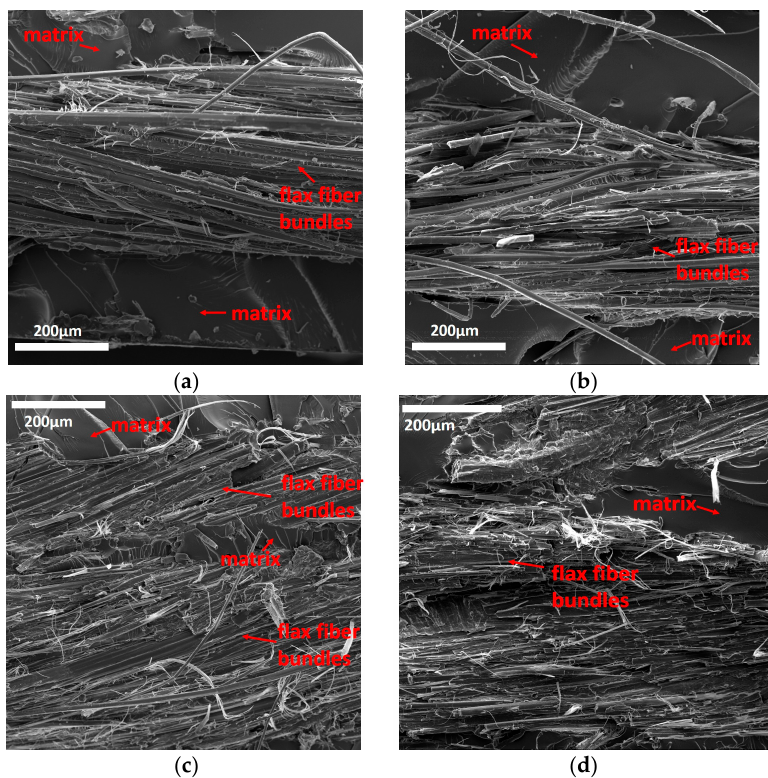
Figure 9. Morphology of fracture surfaces of 90° specimens: ( a ) control group (with untreated flax fibers), 0 h in water; ( b ) control group (with untreated flax fibers), 115 h in water; ( c ) with flax fibers under Treatment 2 (T2), 0 h in water; and ( d ) with flax fibers under Treatment 2 (T2), 115 h in water. Fibers 2018 , 6 , x